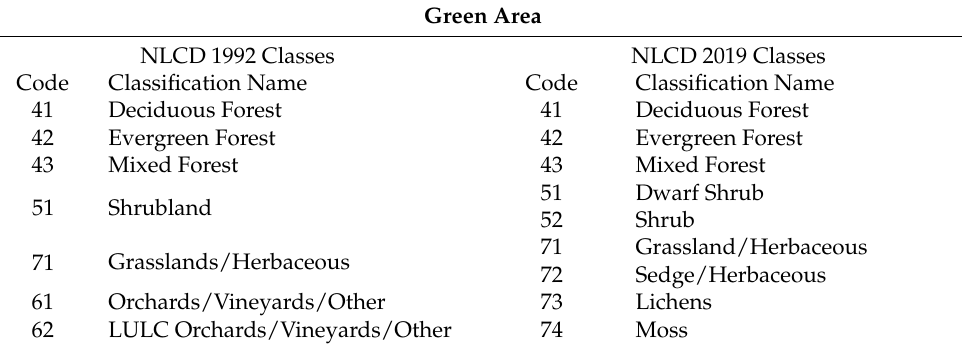
Table 2. Green area classes for 1992 and 2019